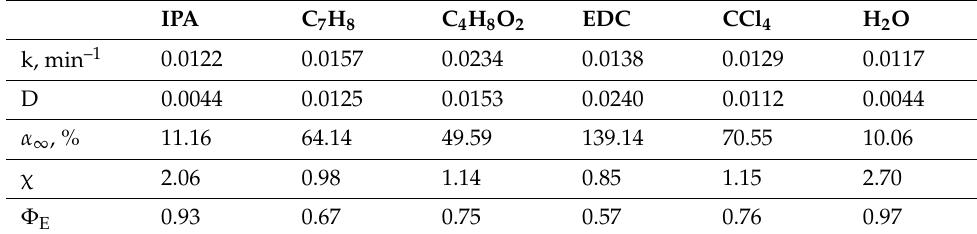
Table 7. Thermodynamic properties of the ‘composite–liquid’ system for the 3610 (NBR) blanket. IPA